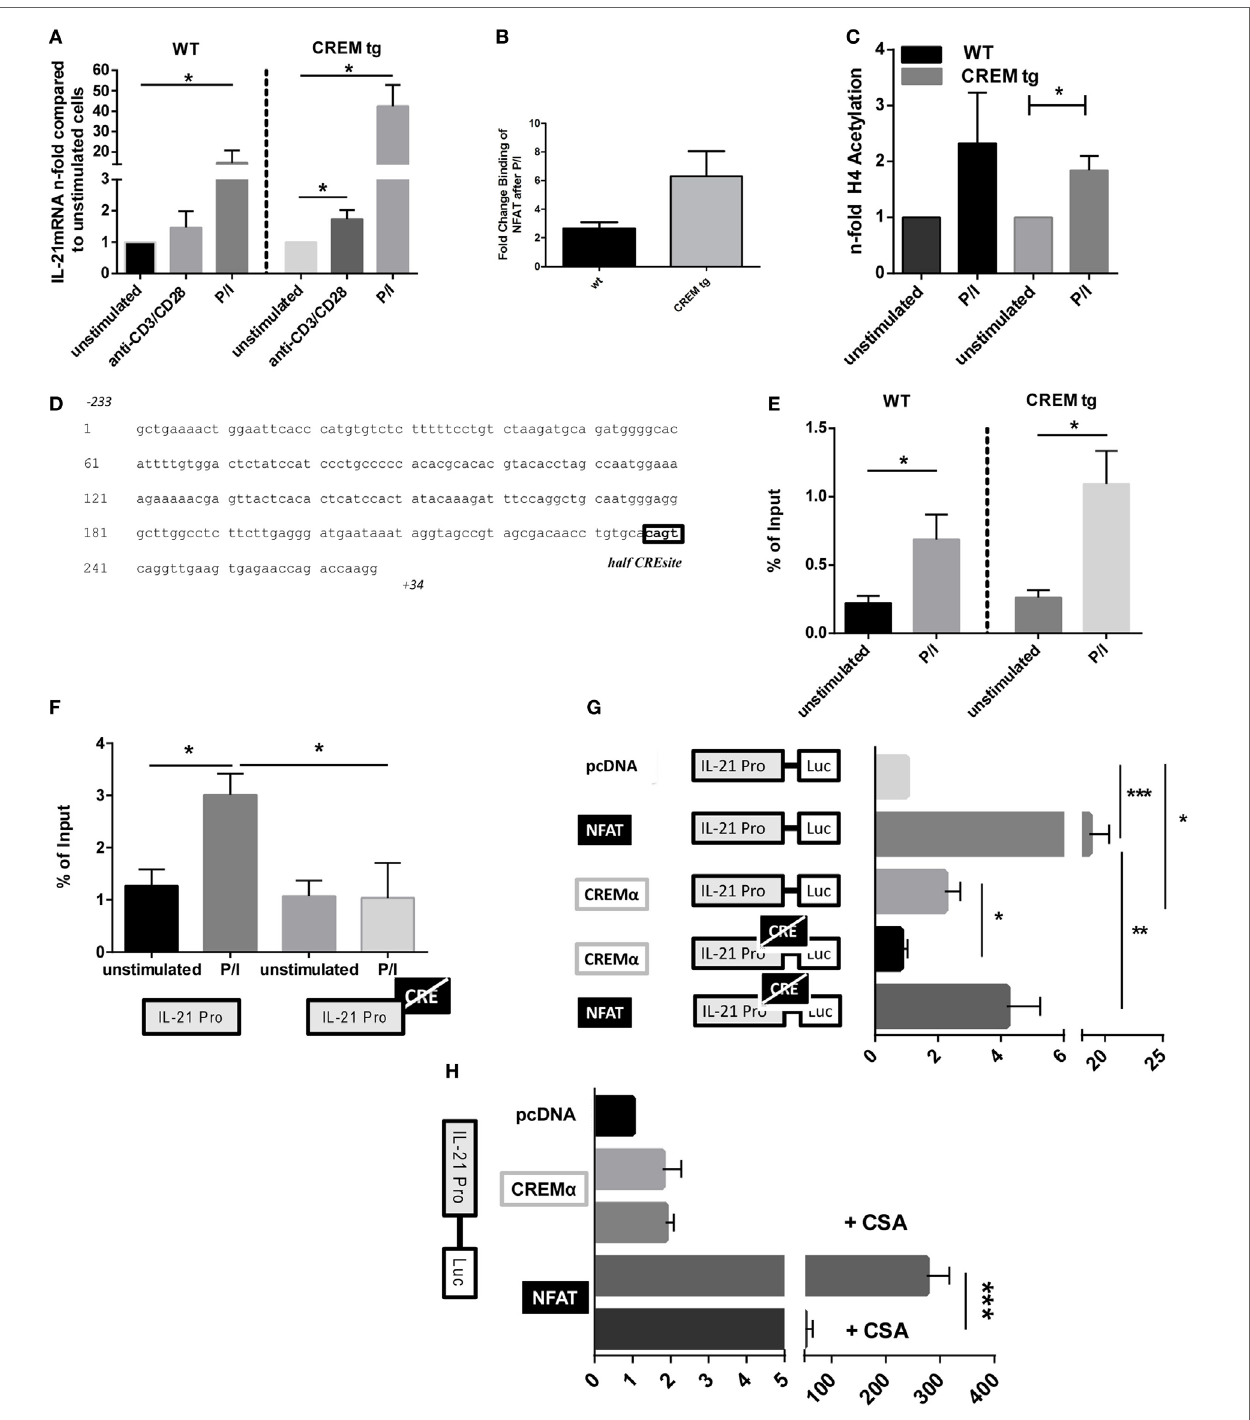
FigUre 3 | caMP-responsive element modulator alpha (creM α ) binds to and directly activates the proximal il-21 promoter region